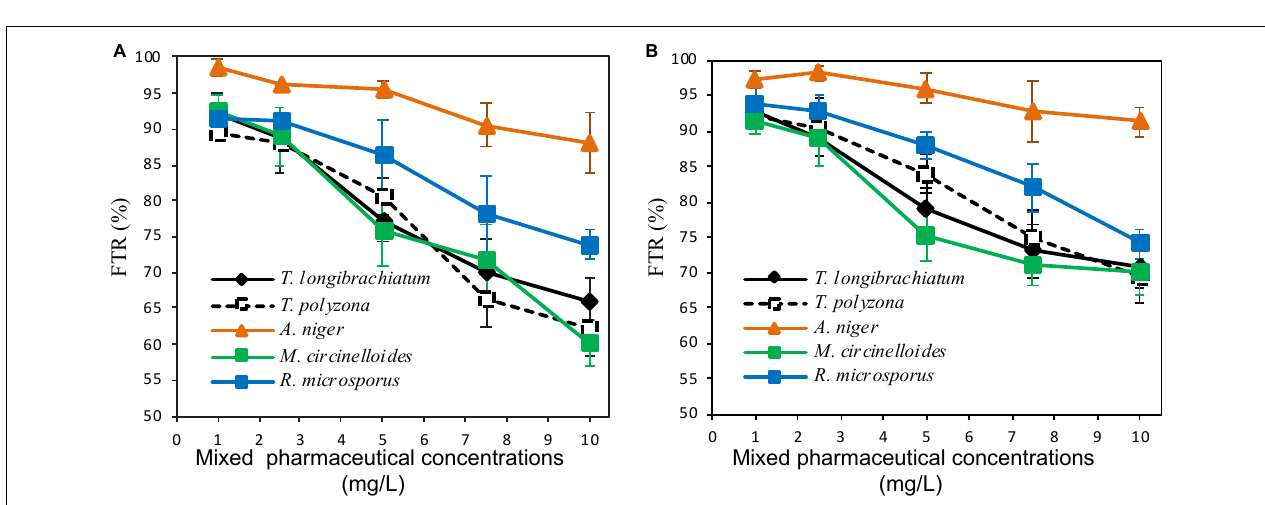
FIGURE 2 | Fungal tolerance to CBZ (A) , DCF (B) , IBP (C) and mixed pharmaceuticals (D) in solid medium.